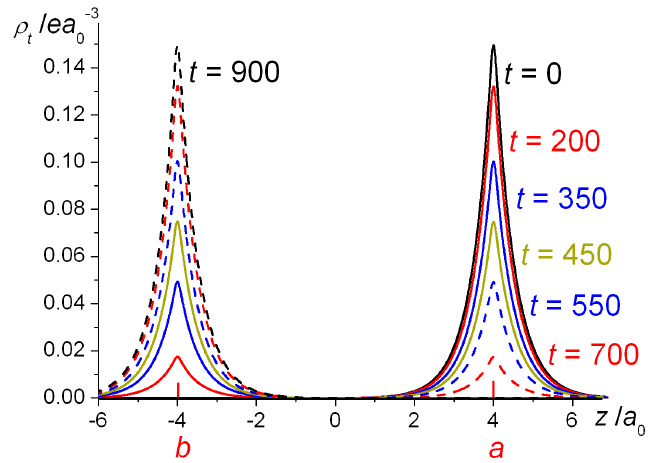
  with x  y  0 as a function of the